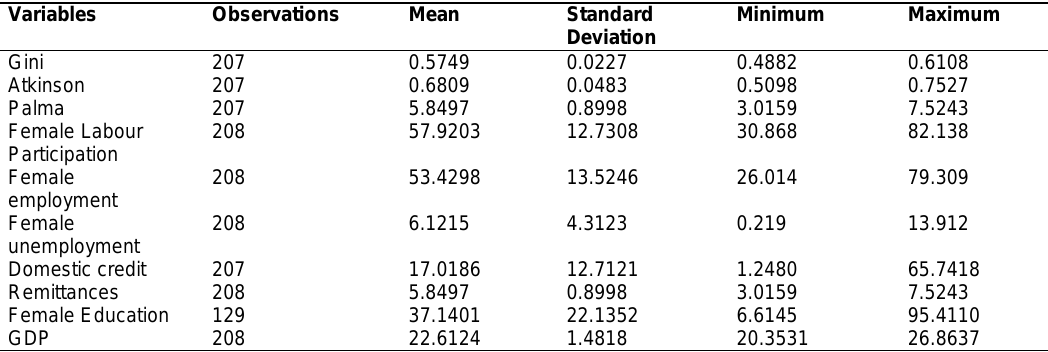
Table 2. Descriptive Statistics of the